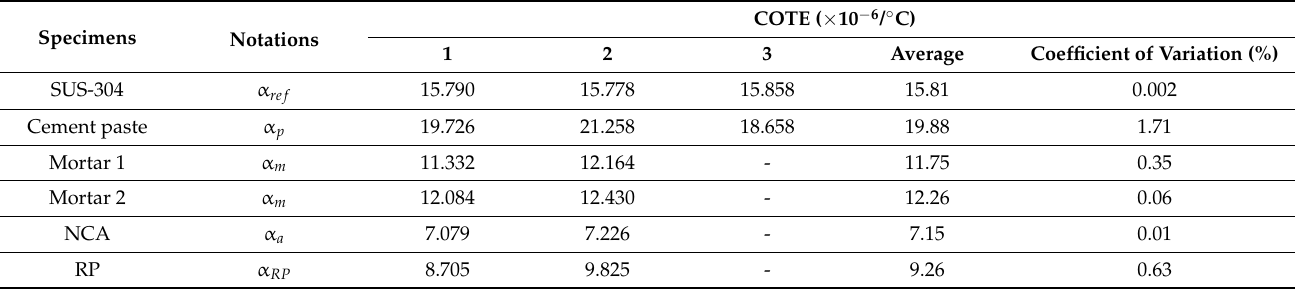
Table 3. Basic COTE values measured from the